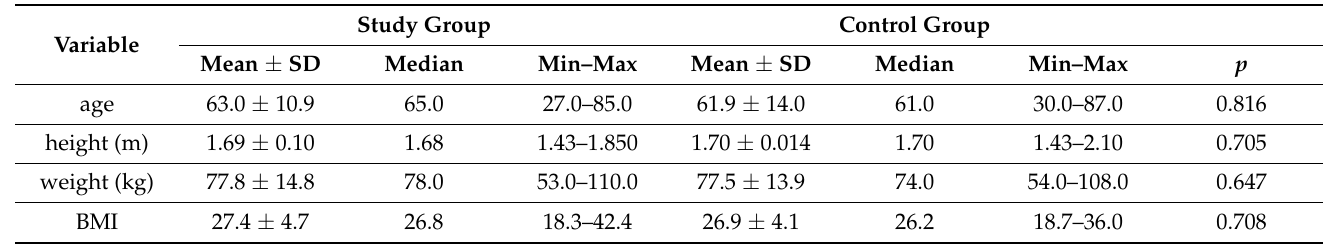
Table 1. Characteristics of the study